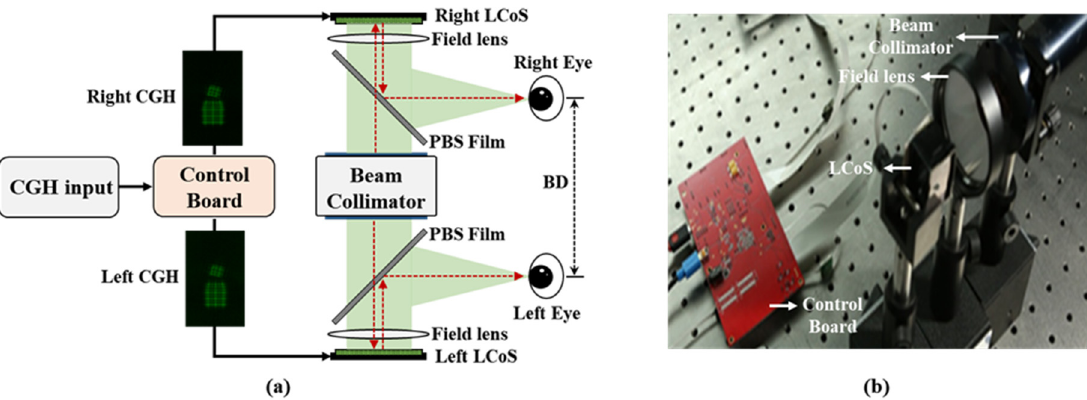
Figure 2. ( a ) Schematic of the dual-view near-eye holographic 3D display (NEHD). ( b ) Prototype setup to demonstrate the proposed NEHD system.